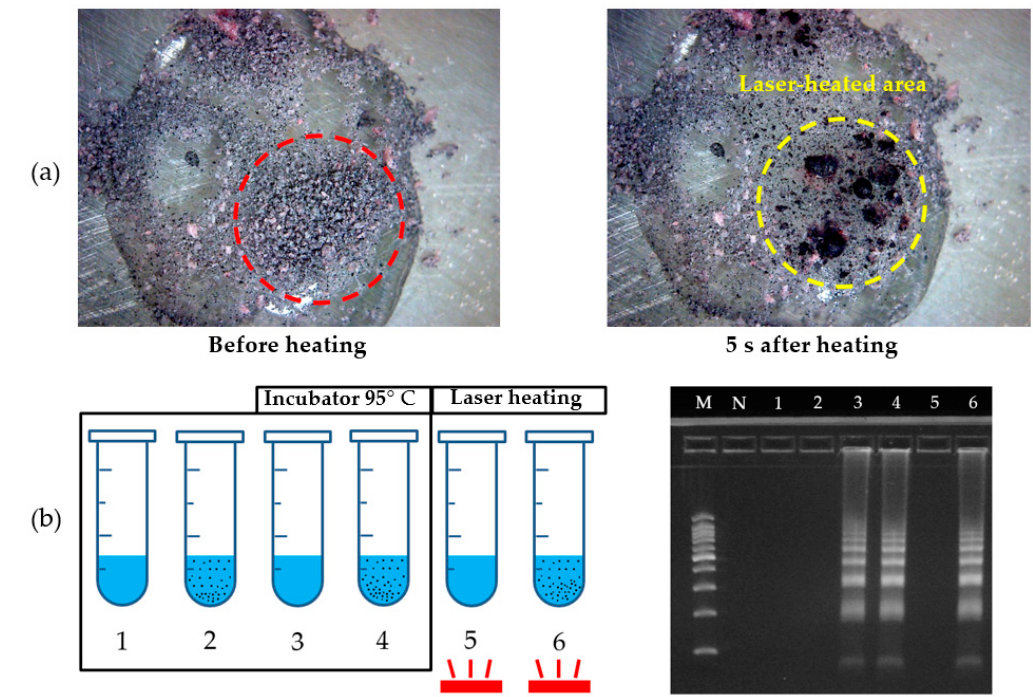
Figure 8. Stability and efficiency test of micro-carbon with DNA. ( a ) Before and after water laser heating with the heat-stick reacting at 95 °C and micro-carbon. The reaction occurred in 5 s, and the heat-stick reaction was used to prove that the micro-carbon reached 95 °C when the laser beam was on. ( b ) All the numbered tubes underwent the same experimental procedure, except for the lysis heating method. Tubes 1 and 2 contained only the sample solution (no DNA), whereas tubes 3–6 contained DNA and sample solutions. Micro-carbon was added to tubes 2, 4, and 6. Tubes 1–4 were heated using an incubator set to 95 °C. A laser beam was applied to tubes 5 and 6. The bottom-right figure shows the electrophoresis result for each tube.